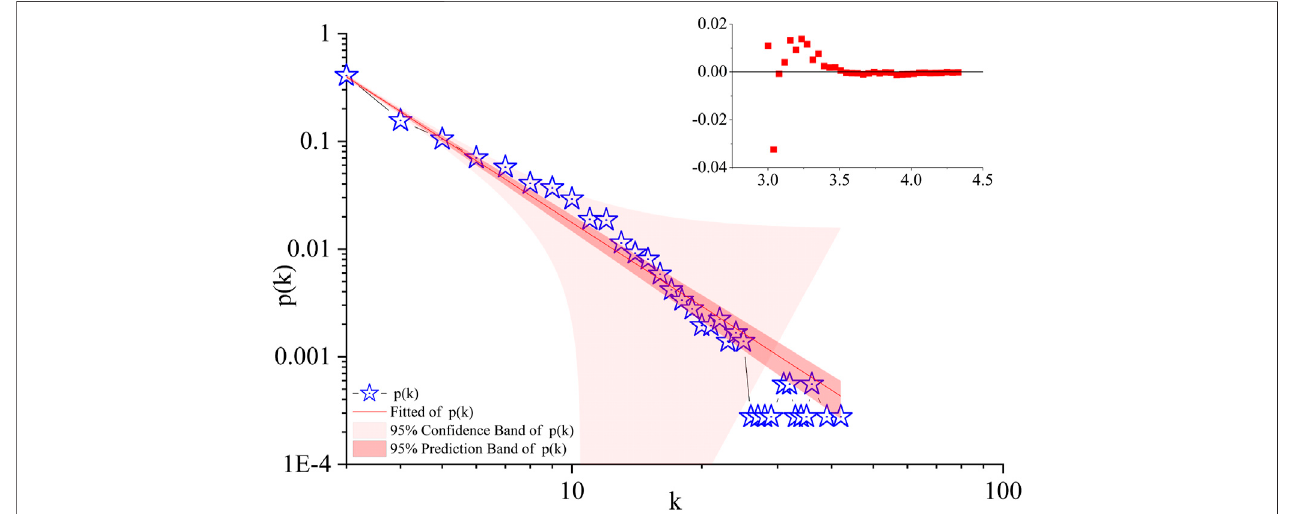
FIGURE 5 | Distribution of temperature network degree in Xi ’ an randomly